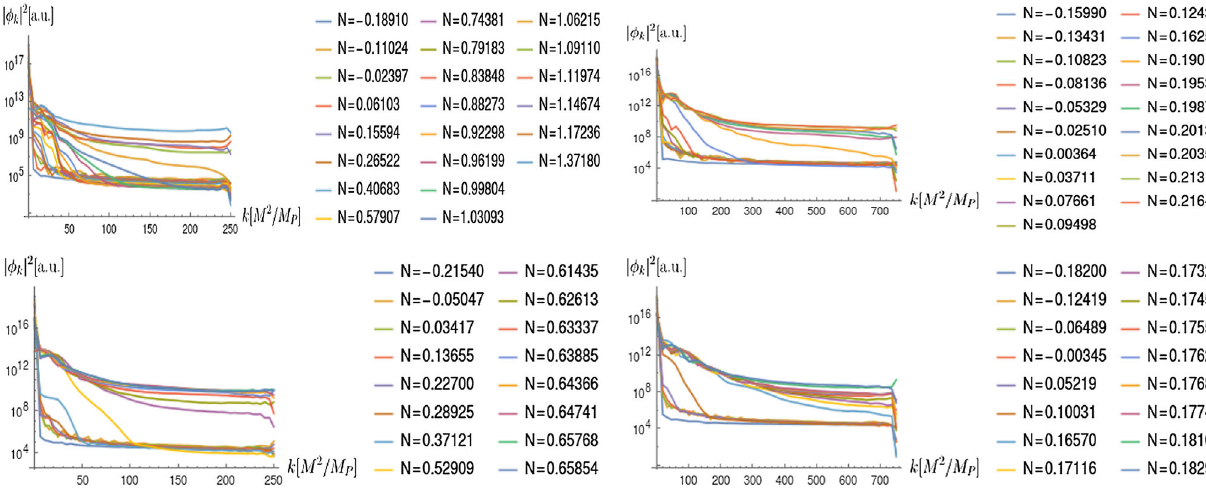
Fig. 14 The power spectrum of the inflaton perturbations for n = 1 , α = 10 − 3 (upper left), n = 1 , α = 10 − 4 (upper right), n = 1 . 5 , α = 10 − 3 (lower left), n = 1 . 5 , α = 10 − 4 (lower right) for different number of e-folds N after the end of inflation. These results were obtained on a lattice with N lattice = 64